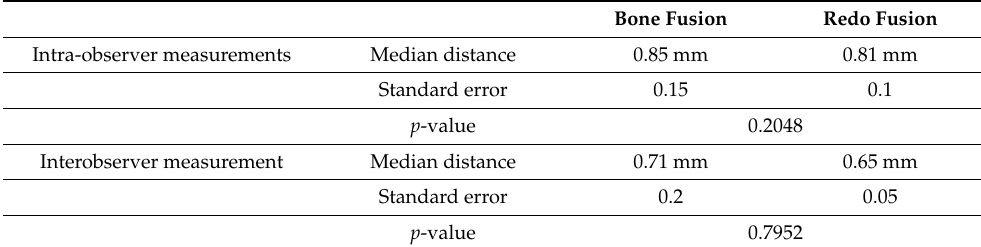
Table 3. Variation between intra-observer and interobserver measurement in L1 and L2.